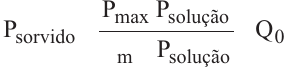
PP soluçãosoluçãomax